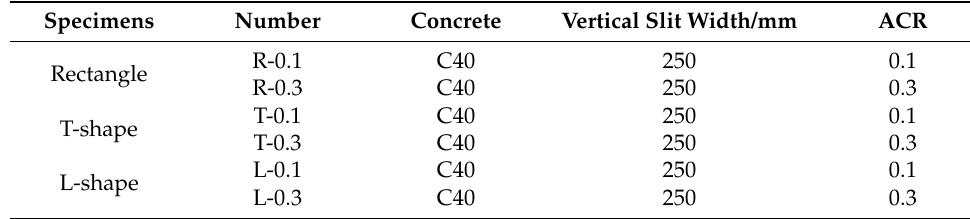
Figure 3. Diagram of node. Table 1. Shear wall specimens.